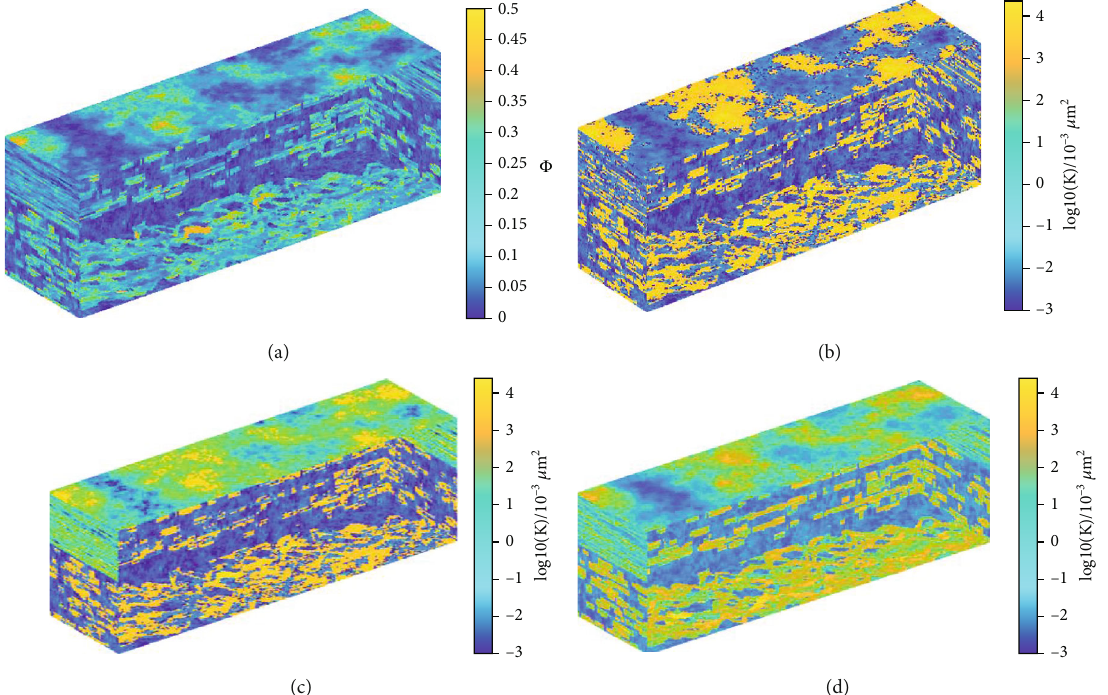
Figure 13: Highly heterogeneous reservoir: (a) the porosity of spe10; (b) fractal permeability of the whole reservoir; (c) fractal permeability of considering di ff erent layers; (d) fractal permeability of considering di ff erent